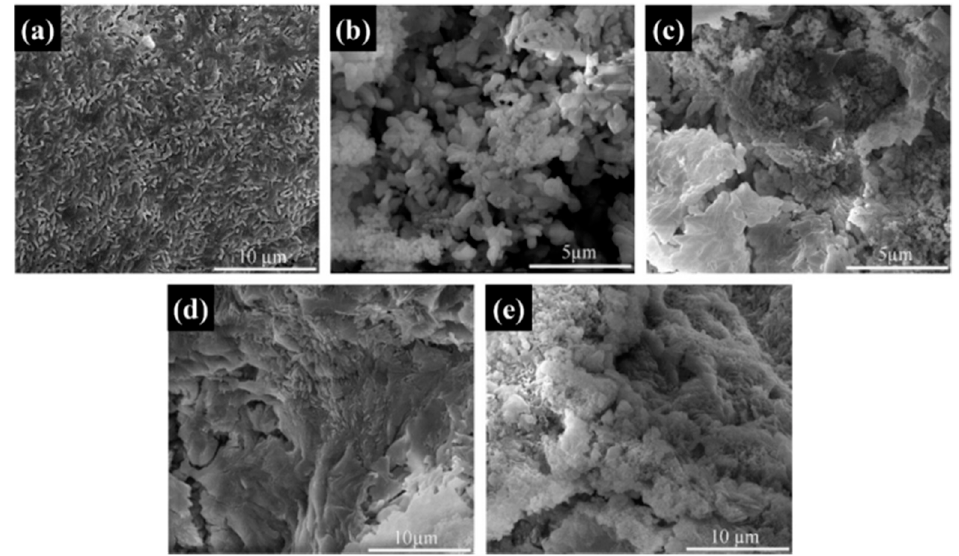
Figure 7. SEM images of ( a ) pure Na 2 SO 4 ·10H 2 O, ( b ) S-PCMs, ( c ) GS-PCMs-1, ( d ) GS-PCMs-2, ( e ) GS-PCMs-3.